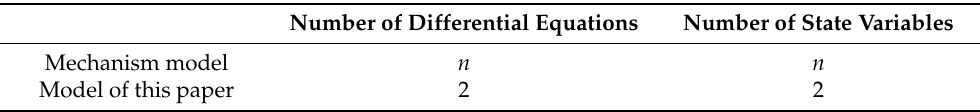
Table 1. Comparison between the number of differential equations and state variables.